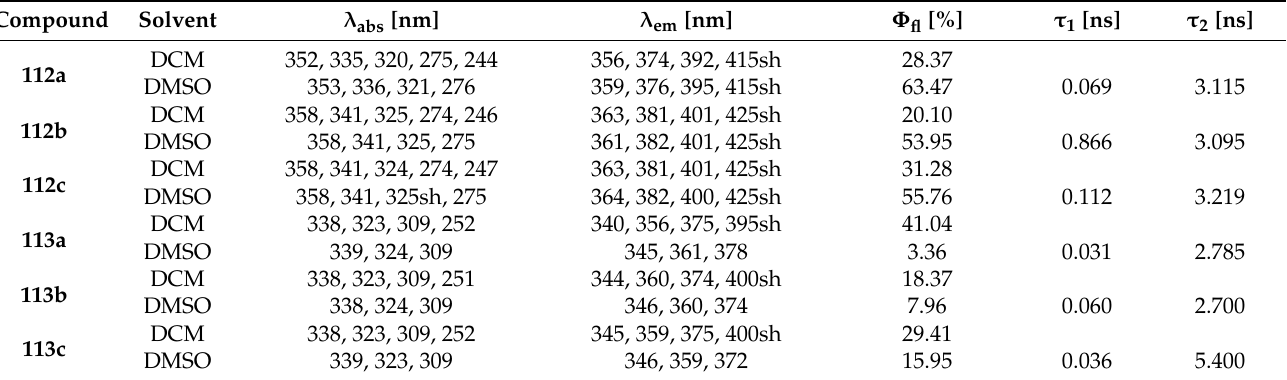
Table 19. Photophysical properties of isoquinoline derivatives.